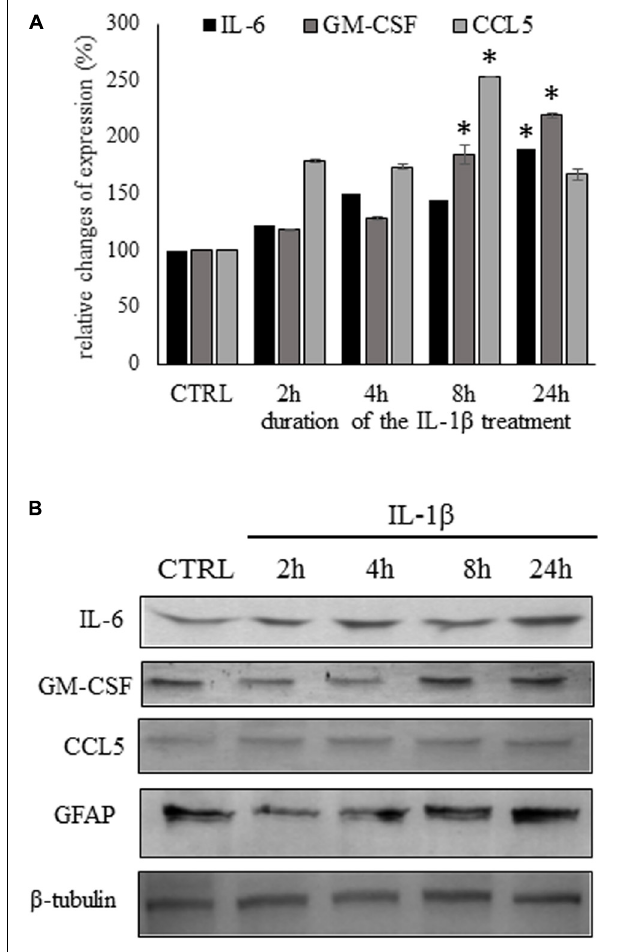
FIGURE 4 | Time course experiments show different kinetics of cytokine secretion due to IL-1 β stimulation. (A) Secretion of pro inflammatory cytokines was significantly increased in the supernatant of IL-1 β stimulated astrocytes by ELISA experiments. Data are shown as mean ± SEM of three independent experiments in duplicate assay. ANOVA Repeated Measures, followed by Tukey’s pairwise comparison, ∗ p < 0.05 versus control group. (B) Representative immunoblots of IL-6, GM-CSF, and CCL5 expression in the supernatans of astrocyte cultures. In the cytosol of astrocyte cultures GFAP expression also shows gradual time-dependent